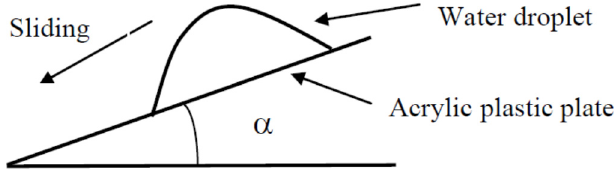
Figure 2. Sliding angle measurement.